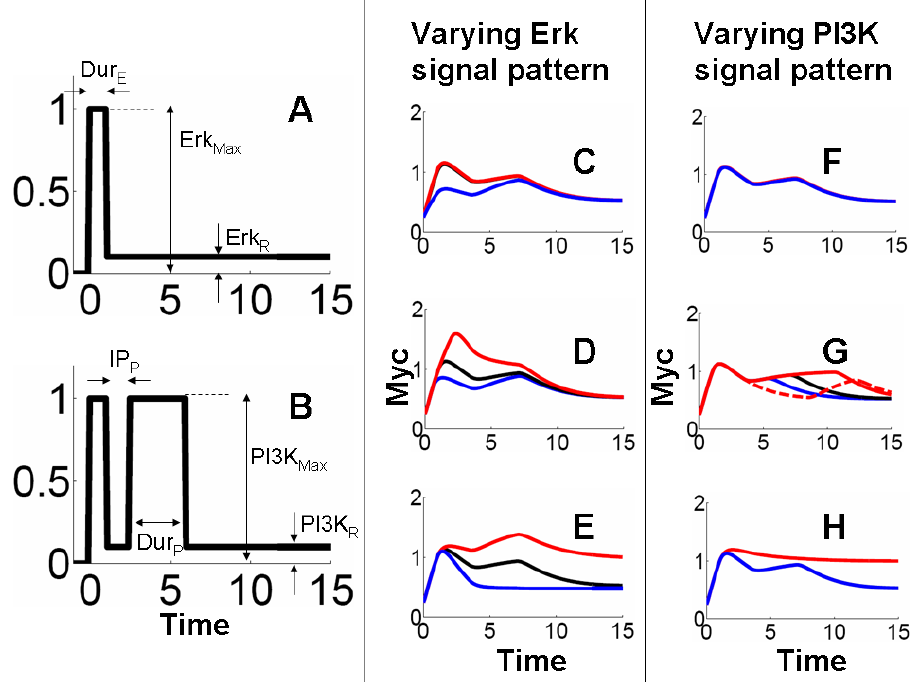
Figure 2. Erk and PI3K signal patterns determine Myc temporal behaviors. For all analyses, black lines represent the base case. (A) The Erk signal was represented with the following parameters: duration (Dur E ), maximal Erk amplitude (Erk Max ), and residual Erk level (Erk R ). (B) The PI3K signal was represented with the following parameters: duration (Dur P ), maximal PI3K amplitude (PI3K Max ), residual PI3K level (PI3K R ), and the time interval between the two peaks of PI3K (IP P ). The first peak of the PI3K was not considered, since its variations did not have a big impact. (C) Myc accumulation was insensitive to Erk Max . Fivefold increase in Erk Max resulted in little change in Myc (red line) in comparison to the base case (black line), whereas fivefold decrease in Erk Max resulted in light reduction in the main peak of Myc (blue line). (D) Doubling (red line) or halving (blue line) Dur E leads to significant change in the initial peak of Myc accumulation. (E) Myc was sensitive to Erk R . The base value of Erk R was 10 percent of Erk Max (black line). A small increase in Erk R (20% of Erk Max ) resulted in excessive Myc accumulation (red line). When Erk was completely removed (Erk R =0), Myc responded only to the initial, transient Erk pulse and became unresponsive to the PI3K signal (blue line). (F) Myc accumulation was insensitive to PI3K Max . Fivefold increase (red line) or decrease (blue line) in PI3K Max resulted in little change in Myc accumulation. (G) The 2 nd PI3K peak determined generation and maintenance of Myc hump. Doubling (red line) or halving (blue line) the duration of the second PI3K peak led to approximately twofold change in the Myc hump duration. Increasing IP P from 3 hours to 8 hours delayed the timing of the second rise in Myc accumulation (red dotted line). (H) A slight increase (20% of PI3K Max ) in PI3K R from the base value (10% of PI3K Max ) resulted in excessive Myc accumulation (red line). However, complete removal of PI3K R did not change Myc accumulation significantly (blue line overlapping with black line).